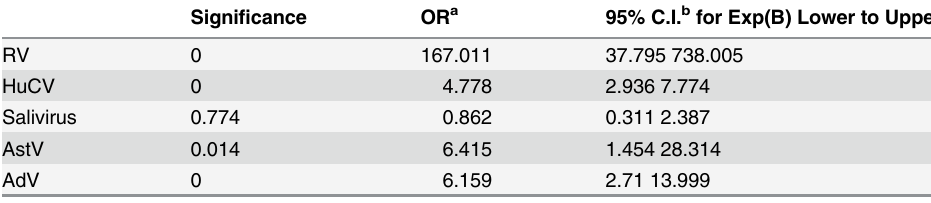
Table 2. Multiple factor Cox regression analysis of the association of five viruses with gastroenteritis ( p <